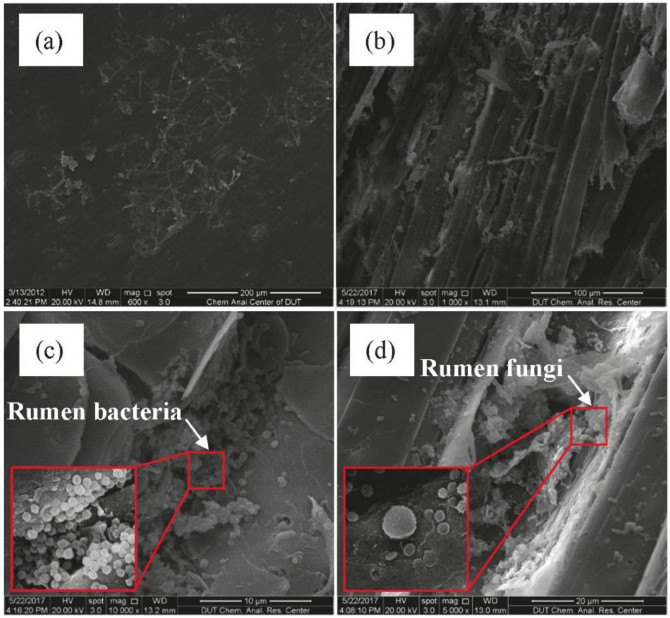
Figure 6. SEM images of: ( a ) undigested CS, ( b ) digested CS, ( c , d ) rumen microorganisms’ adhesion on the surface of